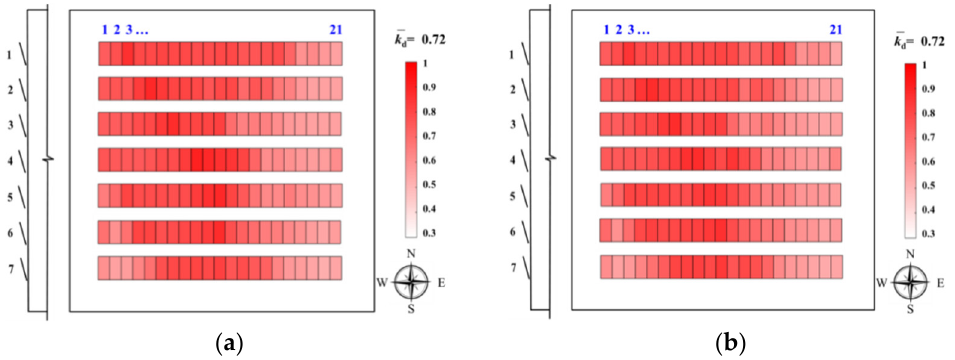
Figure 9. Distributions of directionality factor k d for solar arrays with building orientation α = 0° in Jinan, China, given different extreme wind loading coefficients: ( a ) 57% percentile C 57% ; ( b ) 78% percentile C 78% .